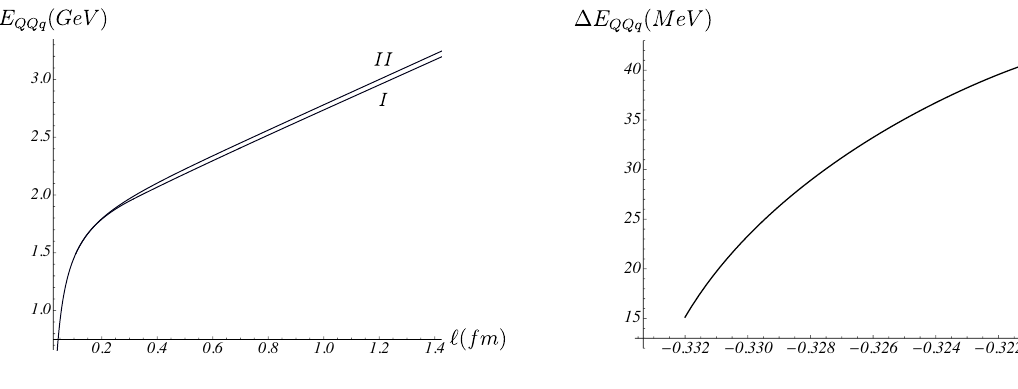
as a function of k . QQq